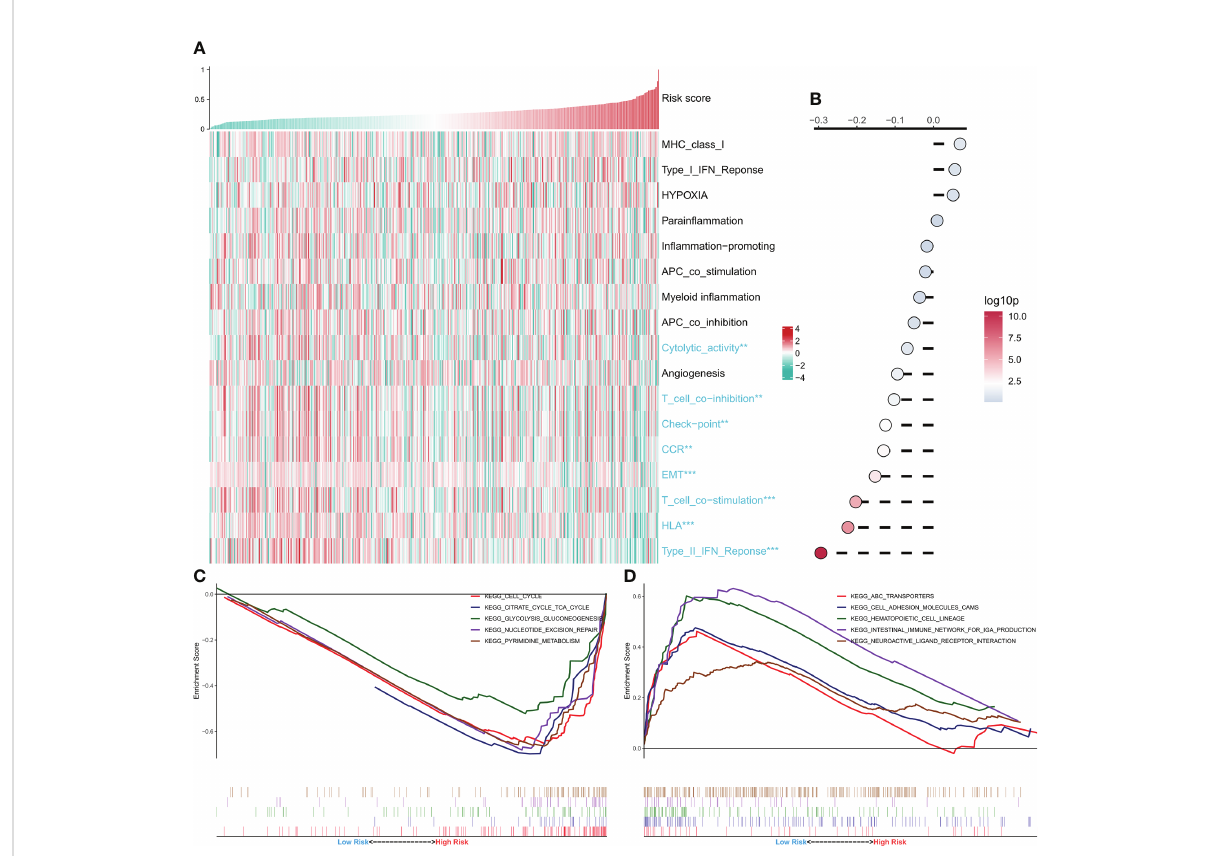
FIGURE 5 Functional analysis of CRGs-related deep learning models. (A) Heat map showing the relationship between Risk score and biological pathway live. (B) Correlation analysis of Risk score and biological pathways. (C) GSEA enrichment map showing the 5 pathways of interest in the high-risk group. (D) GSEA enrichment plot showing the 5 pathways of interest in the low-risk